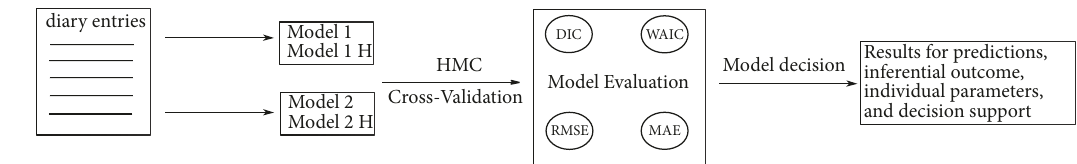
Figure 1: Graphic visualization of